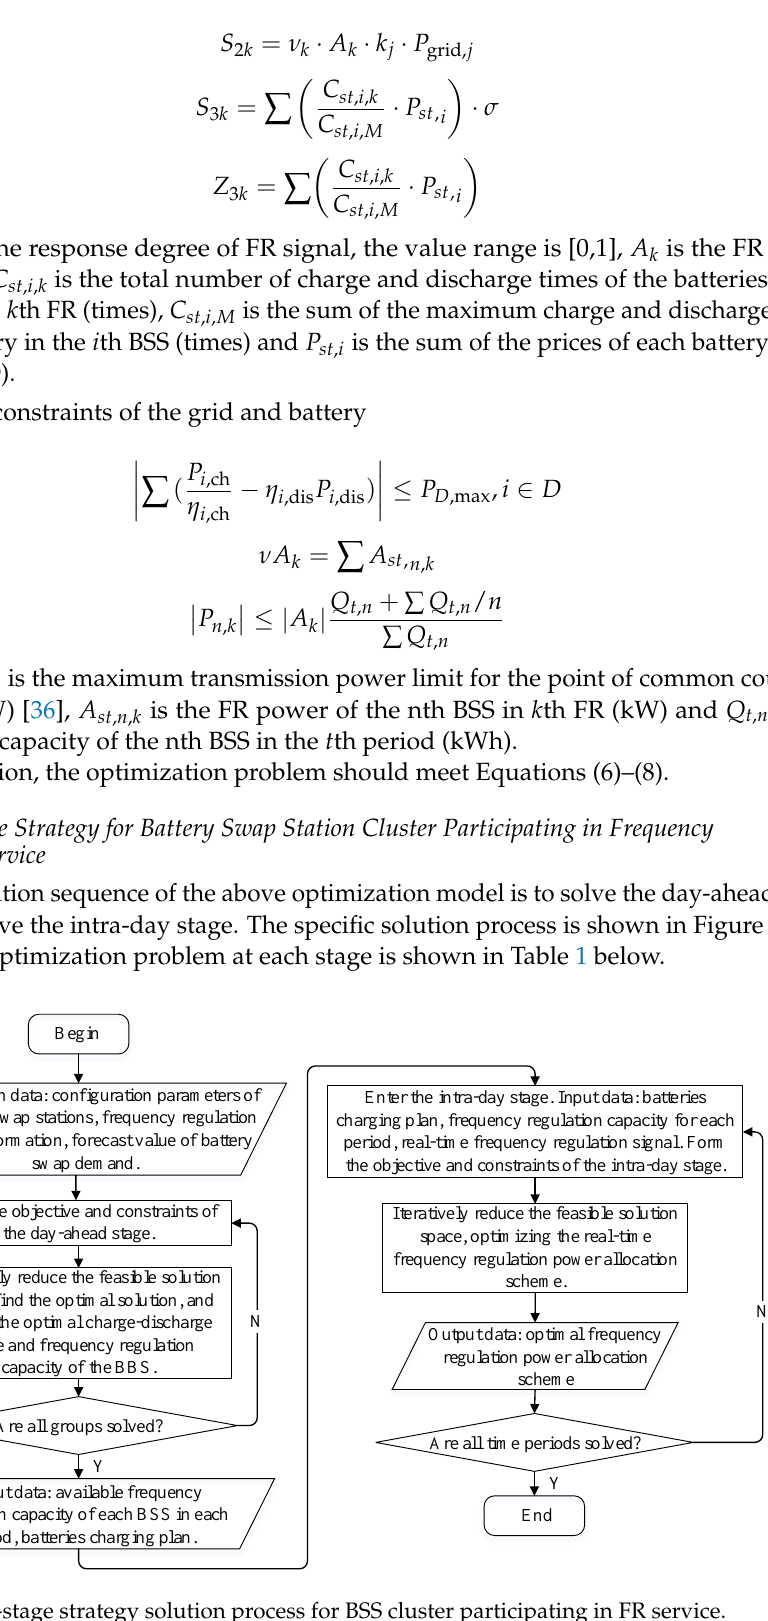
Figure 2. Two-stage strategy solution process for BSS cluster participating in FR service. Table 1. The scale of each optimization problem.